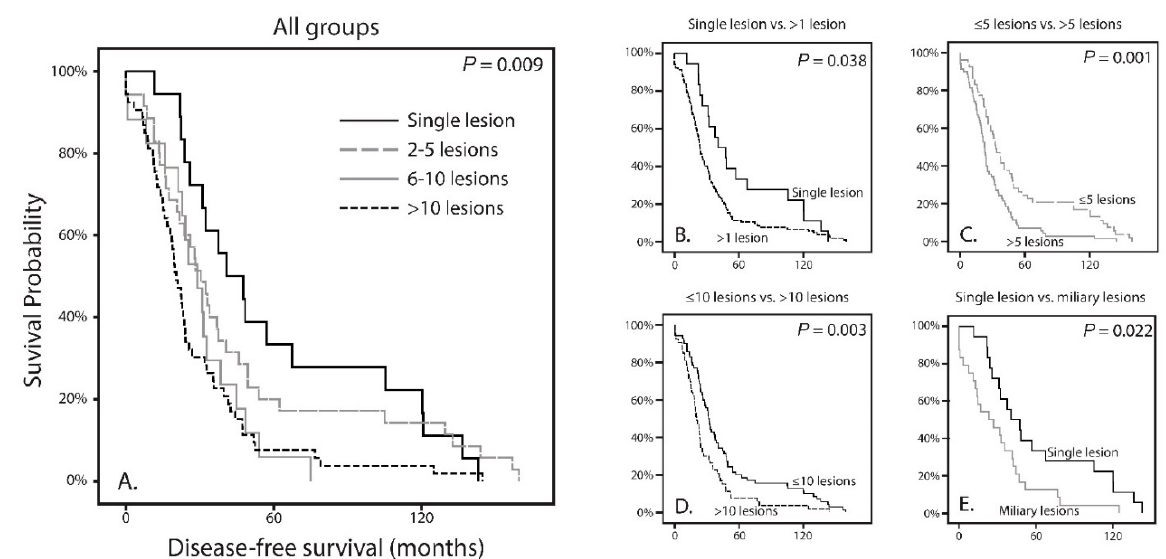
Figure 2. Kaplan-Meier curves showing the disease-free survival of the four classified tumor profiles as well as of multiple comparisons; ( A ) The DFS differs significantly between the groups ( p = 0.009); ( B ) The DFS is significantly more favorable in patients who have a single hepatic lesion compared to patients with more than one lesion ( p = 0.038); ( C ) The DFS is significantly more favorable in patients who have less than five hepatic lesion compared to patients with more than five lesion ( p = 0.001); ( D ) The DFS is significantly more favorable in patients who have less than 10 hepatic lesion compared to patients with more than 10 lesion ( p = 0.001); ( E ) Comparison of patients with a single hepatic lesion with patients who have a miliary hepatic metastatic pattern reveals a worse DFS in the miliary group ( p = 0.022).